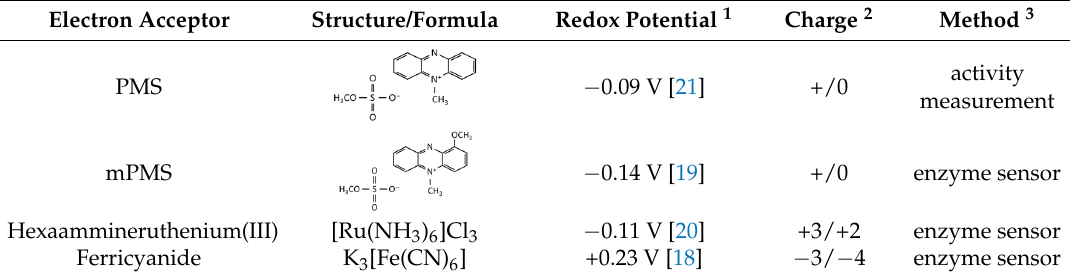
Table 1. Properties of primary electron acceptors in this